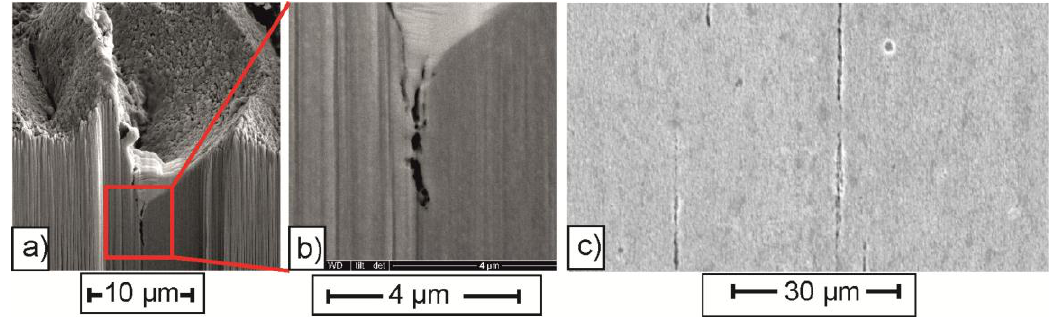
Figure 10. SEM images of shear bands in t-HPT-10 samples ( a , b ) inside the residual fracture surface and ( c ) on the polished and etched cross section.